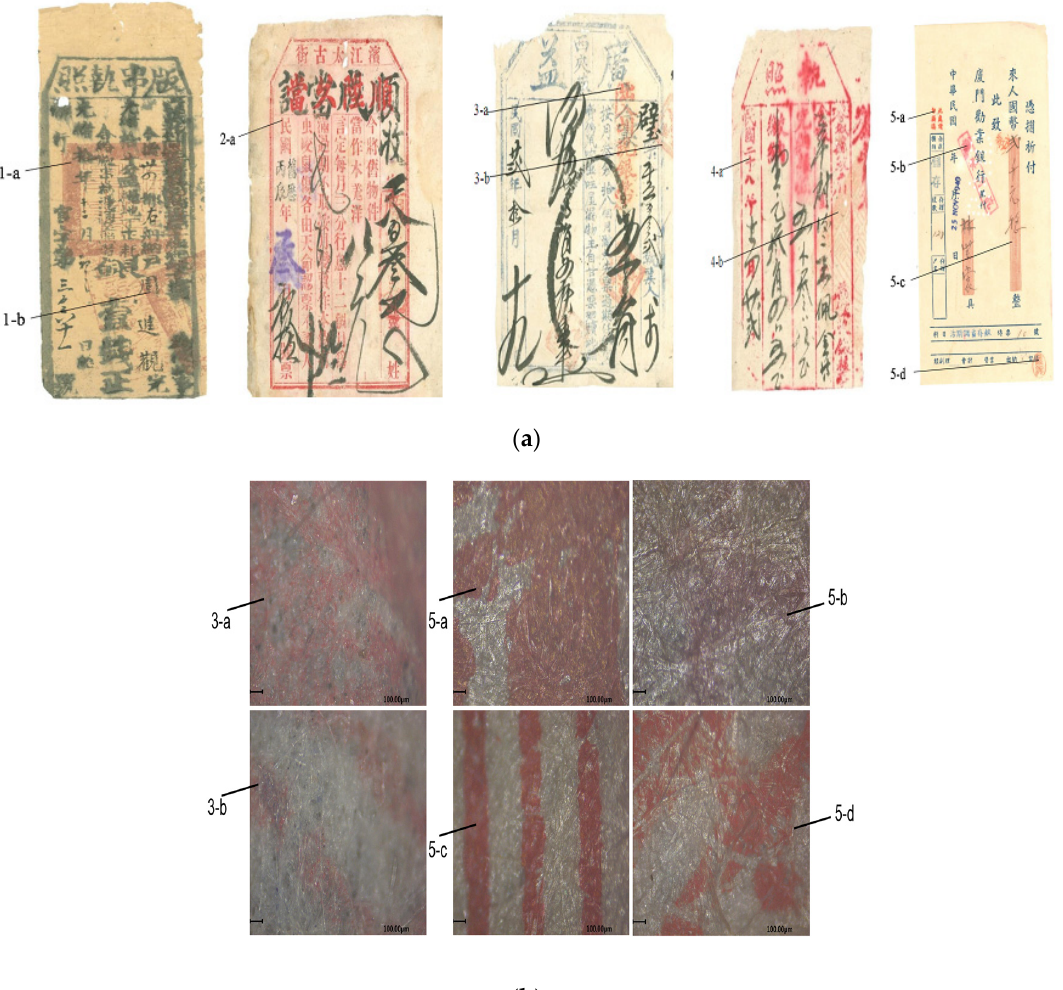
Figure 1. ( a ) Historical Chinese stamps investigated in this study. Selected areas are marked in the figure with small (blue) circles (the dates, from left to right are 1884, 1916, 1933, 1939, 1940). ( b ) The optical microscopy images, taking the points on the pictures of sample 3 and sample 5 as examples.